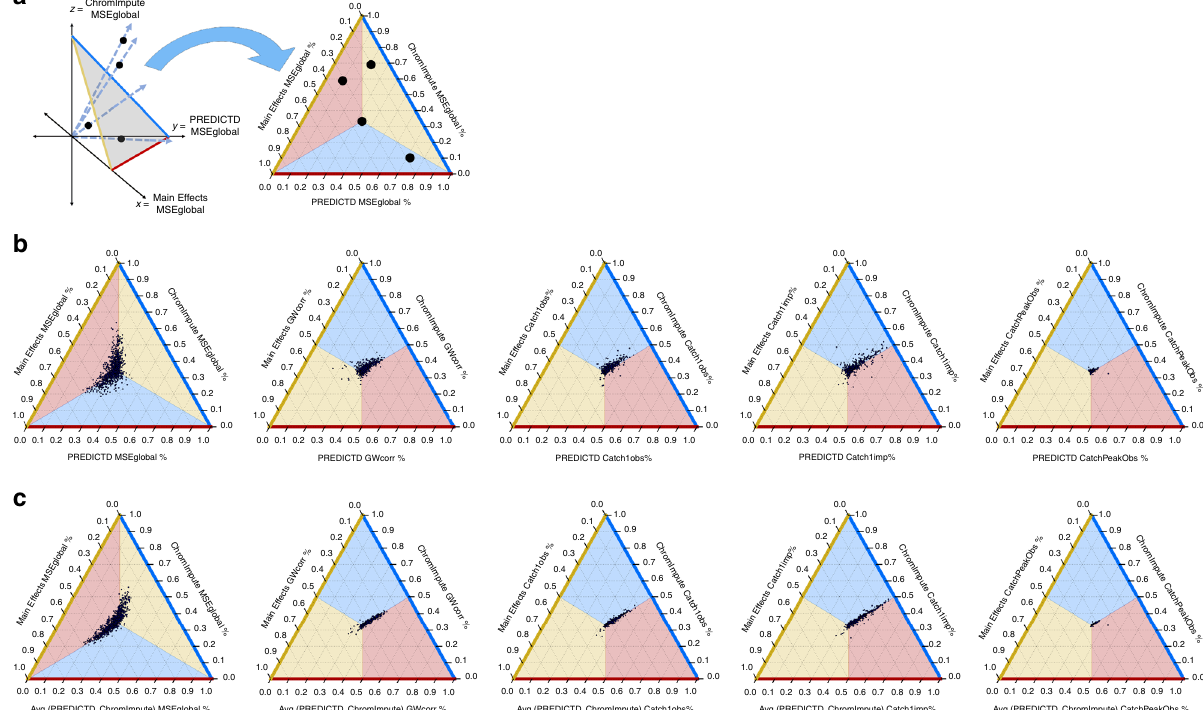
Fig. 4 PREDICTD performs comparably to ChromImpute, and combining the models improves the result. a Schematic describing how a ternary plot relates to Cartesian coordinates. Each experiment (represented by a black dot) is plotted in Cartesian space based on the values of a particular quality score for imputed data (in this example, MSEglobal) from PREDICTD, ChromImpute, and Main Effects. Each point in this space is then projected onto a plane by a vector drawn through the point and the origin. The resulting ternary plot summarizes the relative magnitude of the quality score for the three models. If all models achieve the same quality measure score for a particular experiment, then that point will be projected onto the center of the ternary plot. Deviation toward a corner of the triangle indicates that one model has a higher value for that quality measure than the other two, and deviation from the center toward one of the edges of the triangle indicates that one model has a lower value. Color shading of the plot area marks the regions of the ternary plot that indicate superior performance of each model on a particular quality measure. The pattern of the colors changes based on whether it is better to have a low value on that quality measure (as with mean squared error) or a high value (for example, the genome-wide correlation). b Comparing PREDICTD, ChromImpute, and Main Effects models across fi ve quality measures: the global mean squared error (MSEglobal), the genome-wide Pearson correlation (GWcorr), the percent of the top 1% of observed data windows by signal value found in the top 5% of imputed windows (Catch1obs), the percent of the top 1% of imputed windows by signal value found in the top 5% of observed windows (Catch1imp), and the area under the receiver operating characteristic curve for recovery of observed peak calls from all imputed windows ranked by signal value (CatchPeakObs). c The same as in b , except that the quality measures for the averaged results of ChromImpute and PREDICTD are plotted along the bottom (red) axis, instead of the measures of PREDICTD